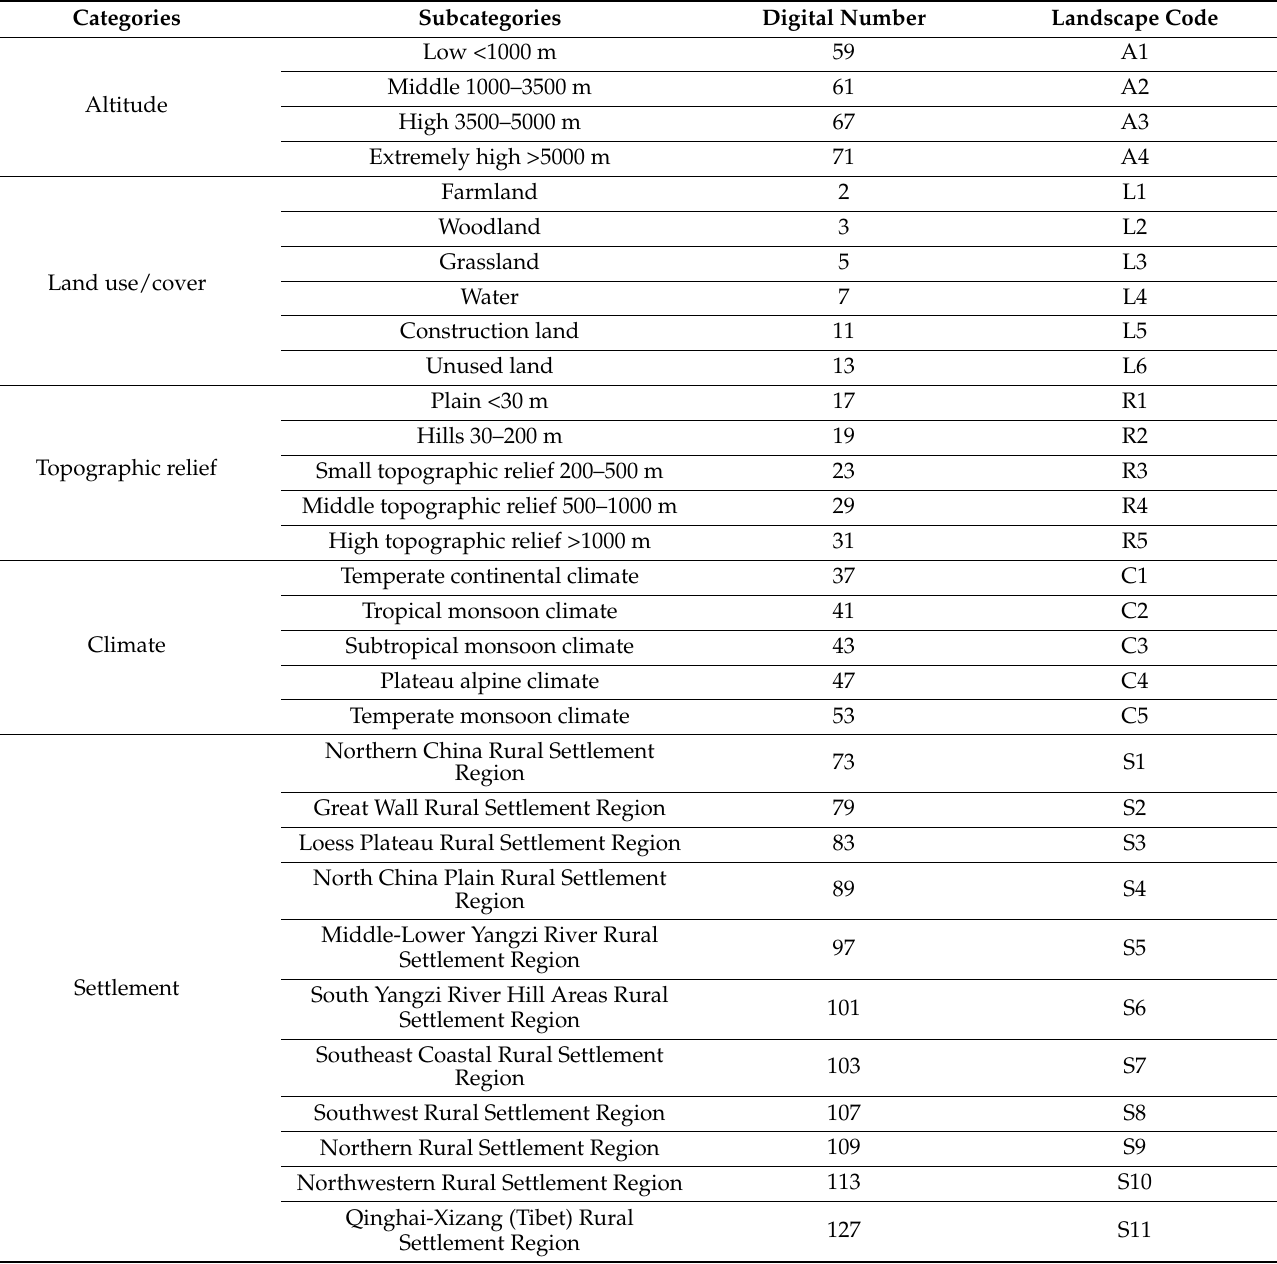
Table A1. Thirty-one landscape characteristic